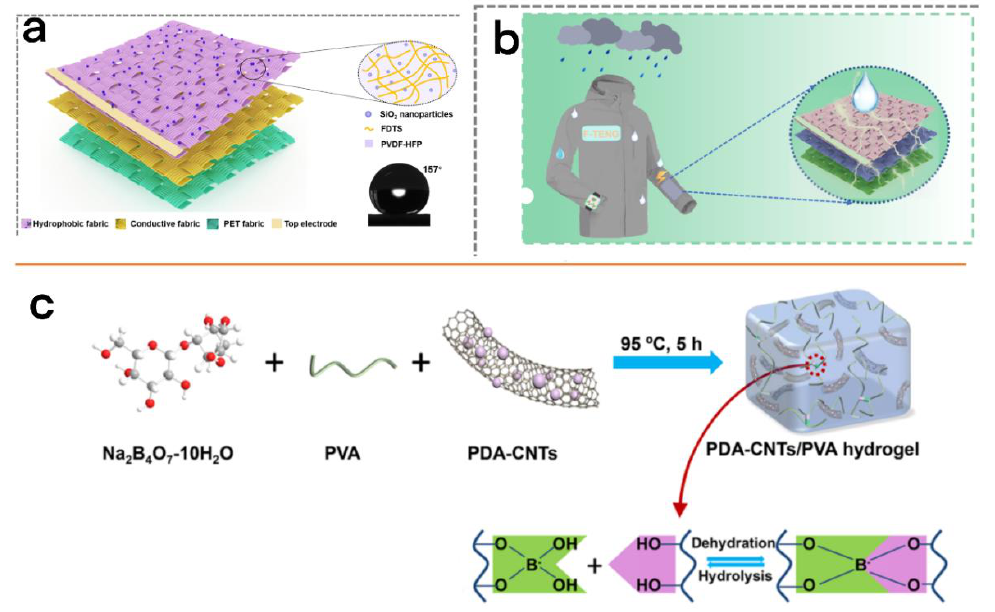
Figure 6. ( a ) Schematic representation of F-TENG. ( b ) The schematic graph shows the application situation of the wearable waterdrop energy collection sense [56]. Ye et al. (2021), ACS. ( c ) Preparation of PDA-CNT/PVA hydrogel and self-healing mechanism of PDA-CNT/PVA hydrogel [57]. Yang et al. (2021), ACS.